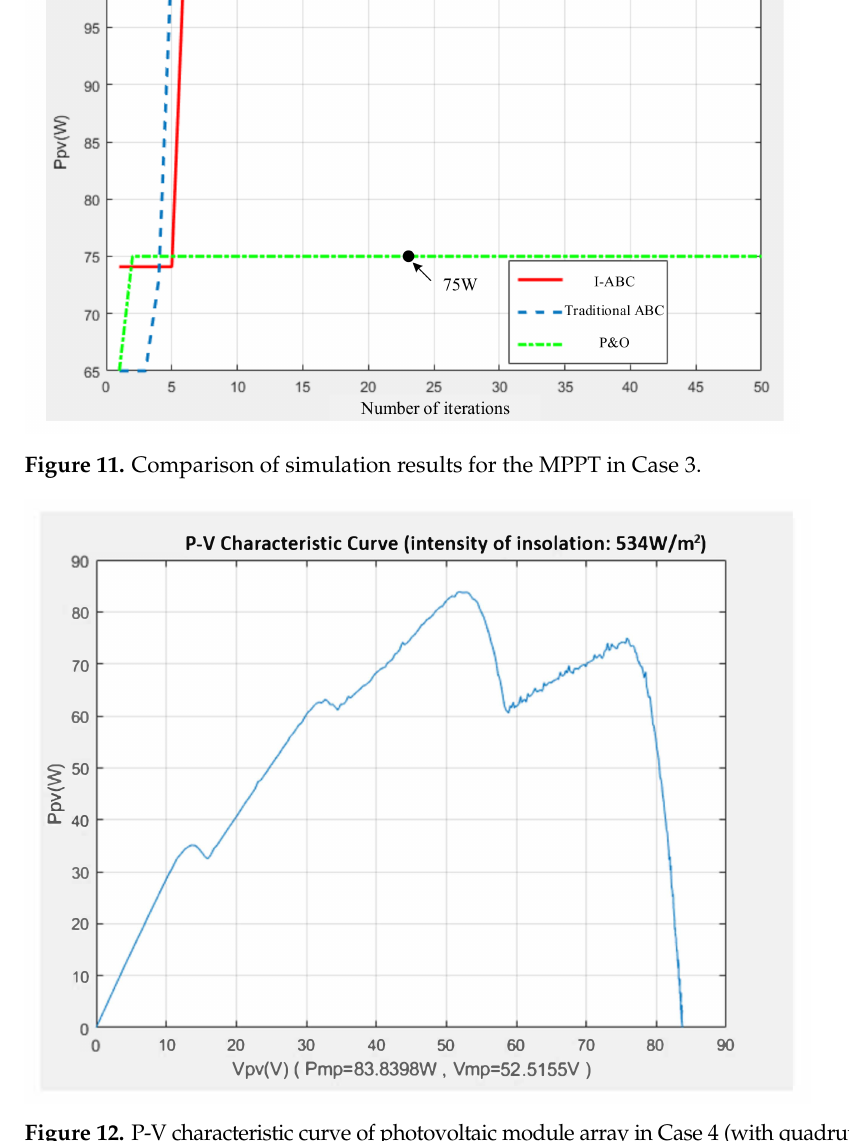
Figure 12. P-V characteristic curve of photovoltaic module array in Case 4 (with quadruple-peak